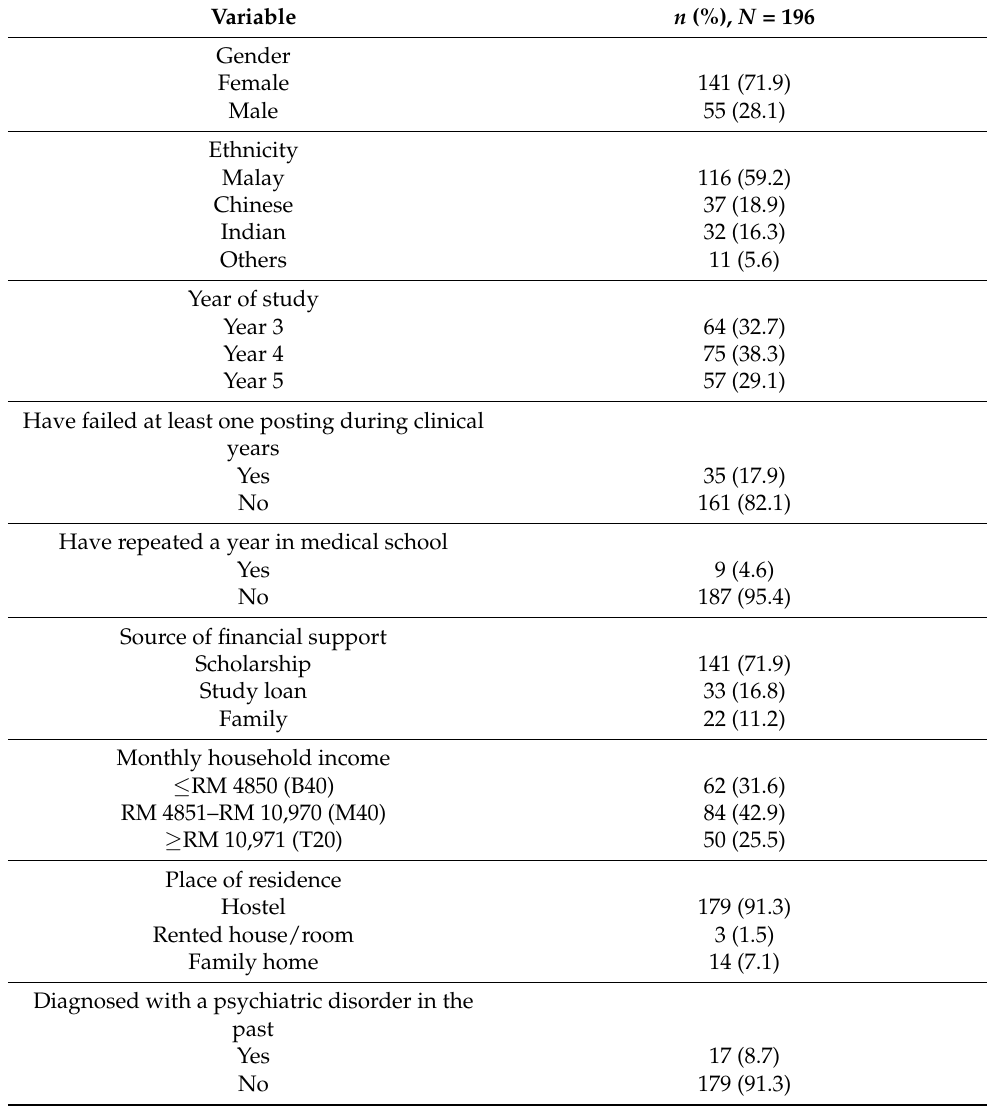
Table 1. Sociodemographic information of respondents and COVID-19-related